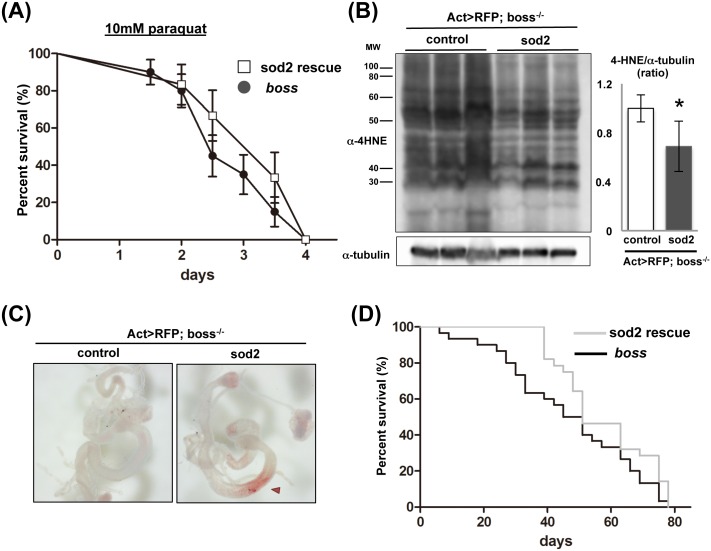
SOD2 overexpression rescues aging phenotype of boss mutant flies.(A) Survival curves of SOD2-overexpressing boss mutant flies (Act-Gal4, UAS-RFP/ UAS-SOD2; boss-/-) and boss mutant flies (Act-Gal4, UAS-RFP/ +; boss-/-) treated with 10 mM paraquat. SOD2 overexpression prolonged the survival of boss mutant flies, shifting the survival curve to the right of the population of SOD2-overexpressing boss mutant flies (n = 30 for each genotypes). Error bars represent S.E. (B) ALEs were detected by Western blot and anti-4HNE antibody. SOD2 overexpression reduced the staining intensity for ALEs (n = 3, 10 flies per replicate). (C) Oil-Red-O staining for neutral lipids in the guts of young (10-days) SOD2-overexpressing control and boss mutant female flies. Anterior midgut region stores lipids (arrowhead). (D) Lifespan for male SOD2-overexpressing boss mutant and boss mutant flies. SOD2 overexpression prolonged the survival of boss mutant flies. Survival was presented by Kaplan Meier curves of SOD2-overexpressing boss mutant and boss mutant flies. n = 50 for each genotypes. Median survival for SOD2-overexpressing boss mutant = 51 days, boss mutant males = 48 days (Log-rank test, p = 0.044).